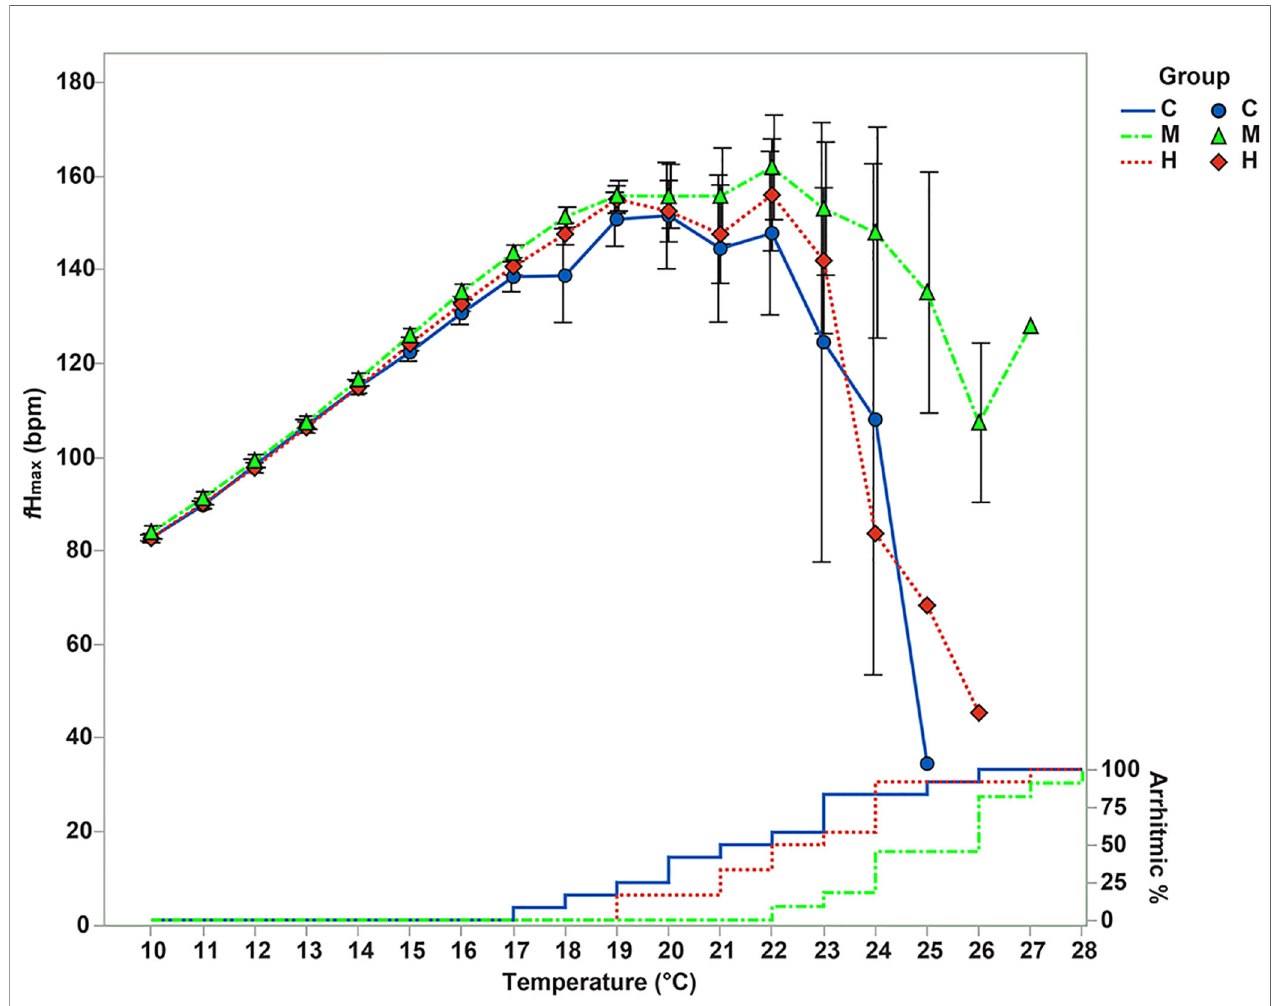
FIGURE 1 | The effects of training programmes on the maximal heart rate ( f H max ) during acute warming. The average ( ± s.e.) f H max of the three training groups (Control=C, blue circles, n=12; Medium intensity=M, green triangles, n=11; High intensity=H, red squares, n=12) during acute warming challenge. The lines on the right side represent the percent of the fi sh that developed cardiac arrhythmia at the corresponding temperature